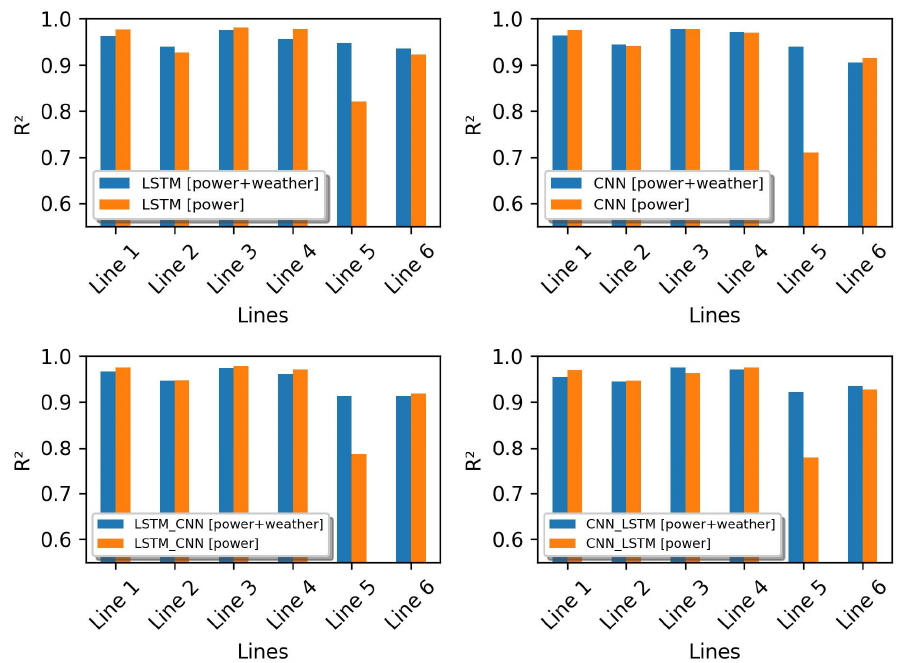
Figure 13. Performance comparison based on the R 2 metric.